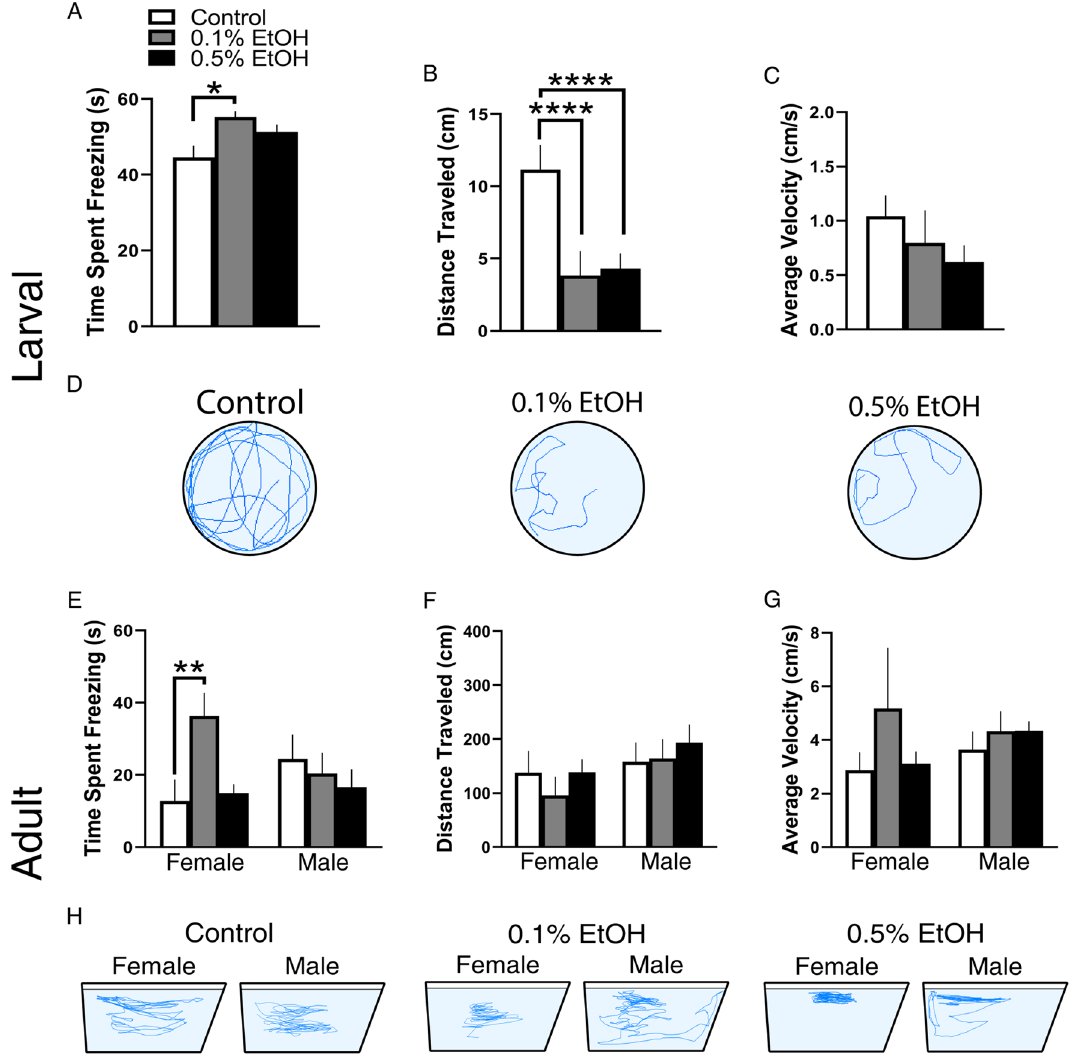
Figure 4. Effects of embryonic EtOH from 22 to 24 hpf on locomotor activity measured in 6 dpf larval and adult zebrafish under novel conditions (min 1) ( A ) EtOH at 0.1% (n = 19) increases time spent freezing in larval zebrafish compared to control (n = 24), with no change in the 0.5% group (n = 30). ( B ) EtOH at 0.1% and 0.5% decreases the distance traveled in larval zebrafish compared to control. ( C ) EtOH at 0.1% and 0.5% has no effect on the average velocity in larval zebrafish compared to control. ( D ) Visual tracking representation of the open- field test as viewed from above showing that embryonic EtOH decreased locomotor activity in larval zebrafish as compared to control. ( E ) EtOH in adult females at 0.1% (n = 8) but not 0.5% (n = 10) increases in min 1 the time spent freezing compared to the control (n = 9), with no changes occurring in adult males at 0.1% (n = 10) or 0.5% (n = 7) relative to control (n = 8). ( F ) EtOH at 0.1% and 0.5% has no effect on the distance traveled in both male and female adult zebrafish compared to control. ( G ) EtOH at 0.1% and 0.5% has no effect in min 1 on the average velocity in both male and female adult zebrafish. ( H ) Visual tracking representation as seen from the side in the novel tank test. Results are shown as means ± standard errors. *p < 0.05, **p < 0.01, ****p <